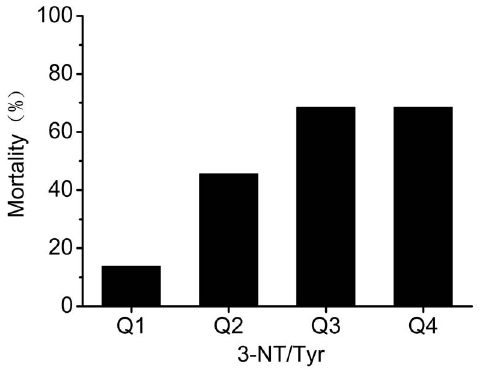
Figure 5. 90-day overall mortality according to quartiles of 3- NT/Tyr ( x 2 =17.6, p =0.001).